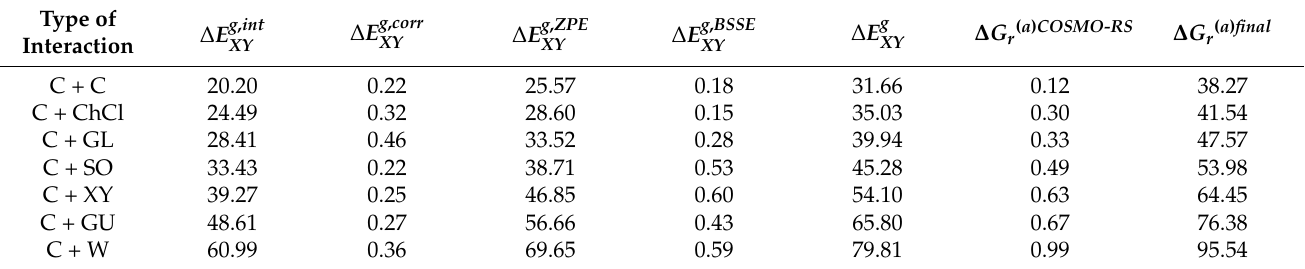
Table 1. The values of intermolecular interactions (in kcal/mol) of caffeine in ccNADES